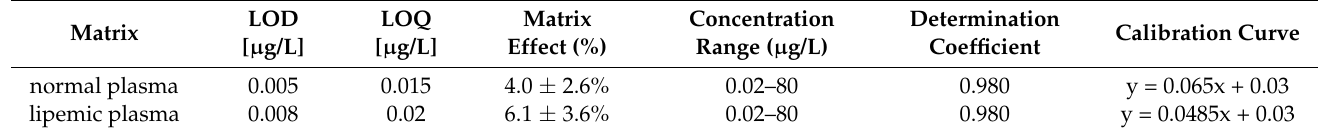
Table 1. Validation report for fentanyl.